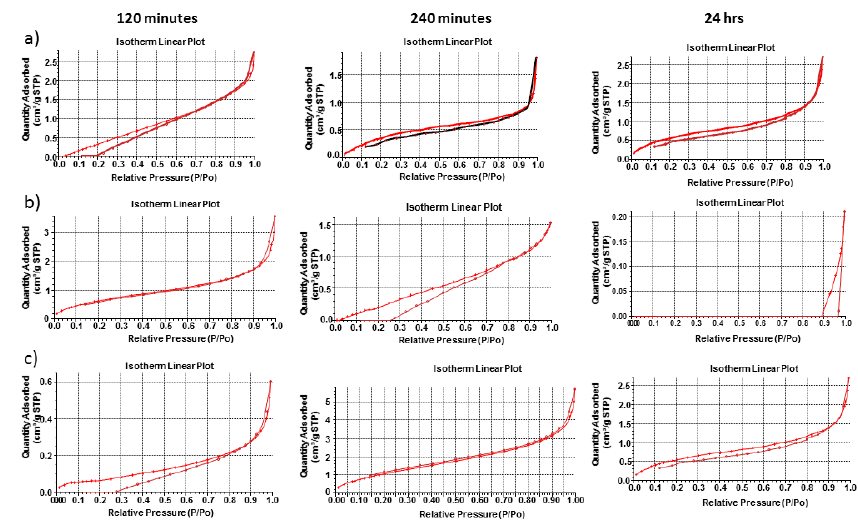
Figure 5. Linear plot isotherms of the hydrogel over 24 h in ( a ) intestinal simulated medium (pH 6.8); ( b ) gastric simulated medium (pH 1.2) and ( c ) deionized water (pH 7).